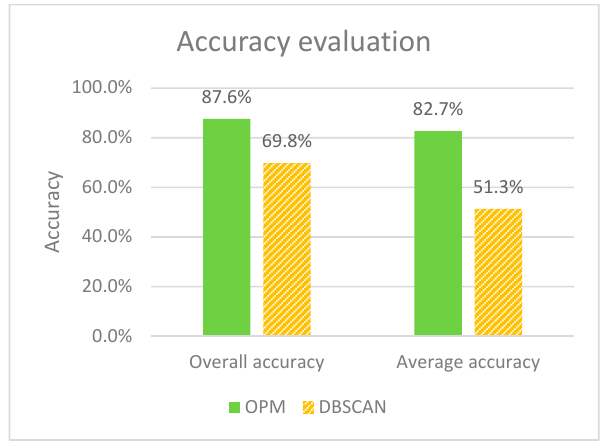
Figure 12. Accuracy evaluation of Our Proposed Method (OPM) and the DBSCAN method.